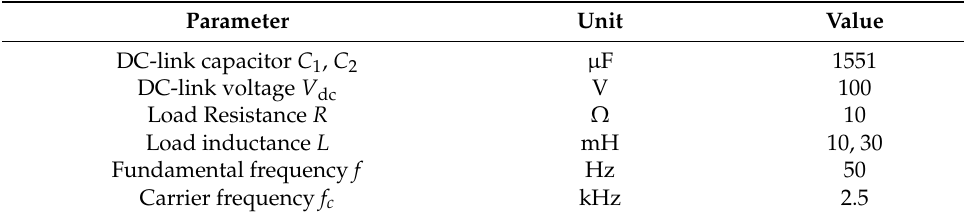
Table 6. Experimental parameters of the